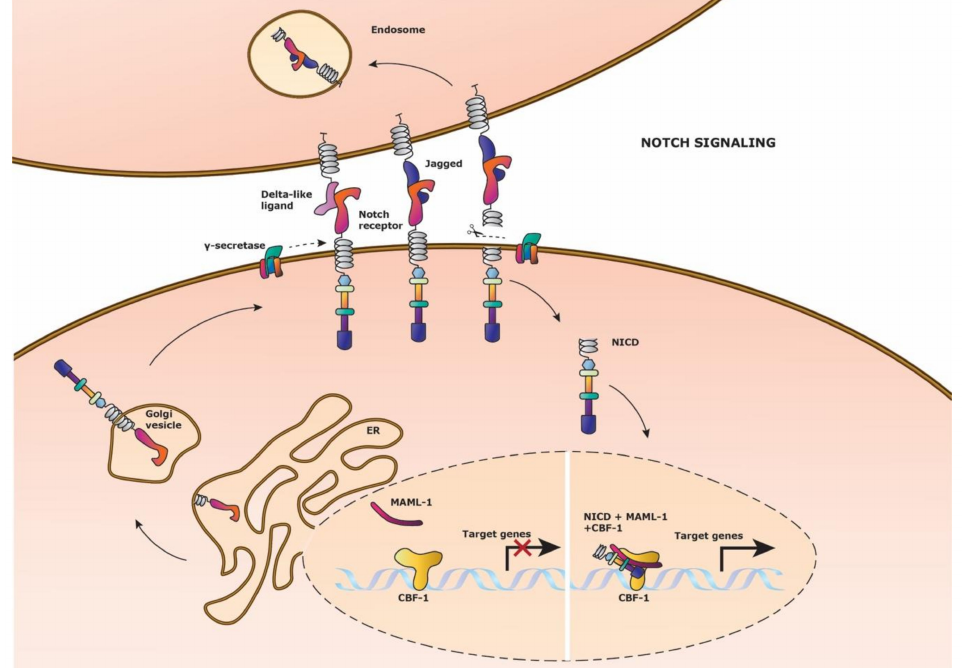
Figure 2. Notch signaling pathway. Schematic representation of the Notch signaling pathway. Notch signaling is activated by Delta-like ligand or Jagged ligand expression on a neighboring cell which binds to the Notch receptor. γ -secretase cleaves o ff the intracellular domain of the Notch receptor (NICD), which then translocates to the nucleus to form a transcriptional activation complex. NICD and co-activator Mastermind (MAML-1) binds to the DNA binding protein Centromere Binding Factor1 (CBF-1) to initiate Notch target gene expression. (Left side nucleus) After Notch signaling has occurred, the NICD and MAML-1 detaches from CBF-1, to which NICD is recycled into the cytosol. The Notch receptor is replenished by fusion of the newly formed extracellular Notch receptor domain and the NICD on the cell membrane for ligand